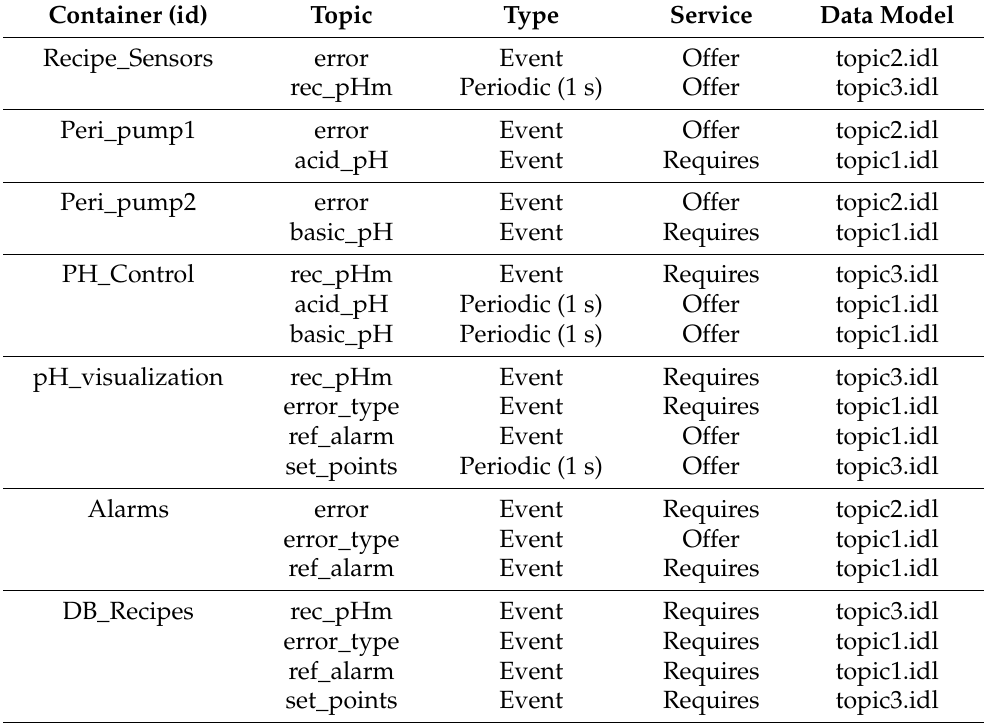
Table 2. Relationship of implementation features with containers, topics, services, and their data